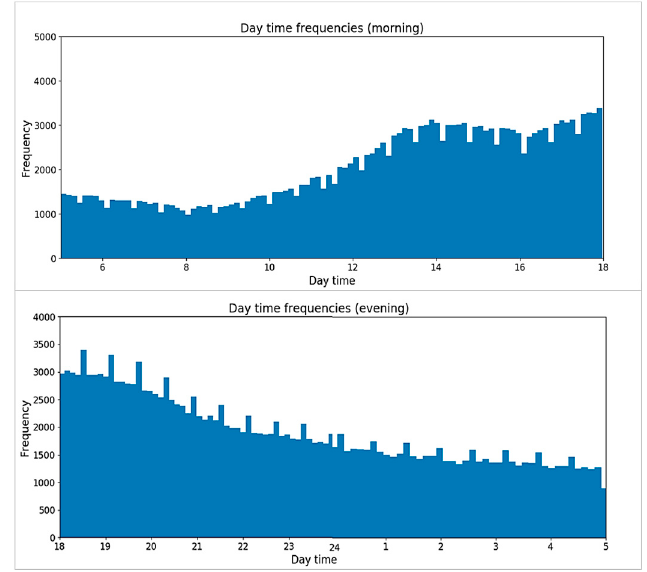
Figure 4. Day time frequencies of plays during the morning intervals and the evening intervals.